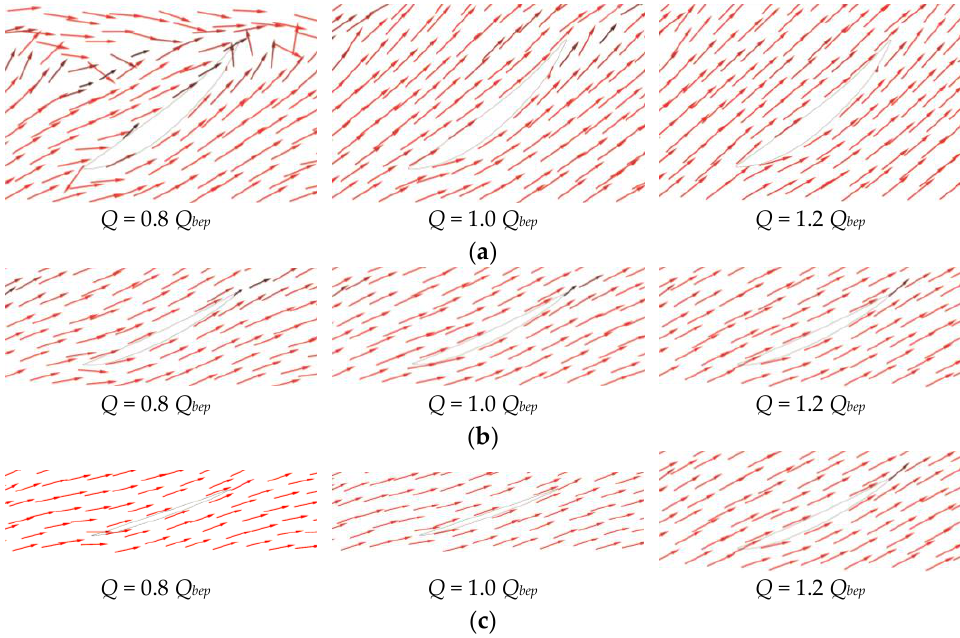
Figure 11. Flow pattern of the impeller: ( a ) span = 0.1 (near the hub); ( b ) span = 0.5; ( c ) span = 0.9 (near the shroud). In each picture, there are impeller inlets at the bottom and impeller outlets at the top.